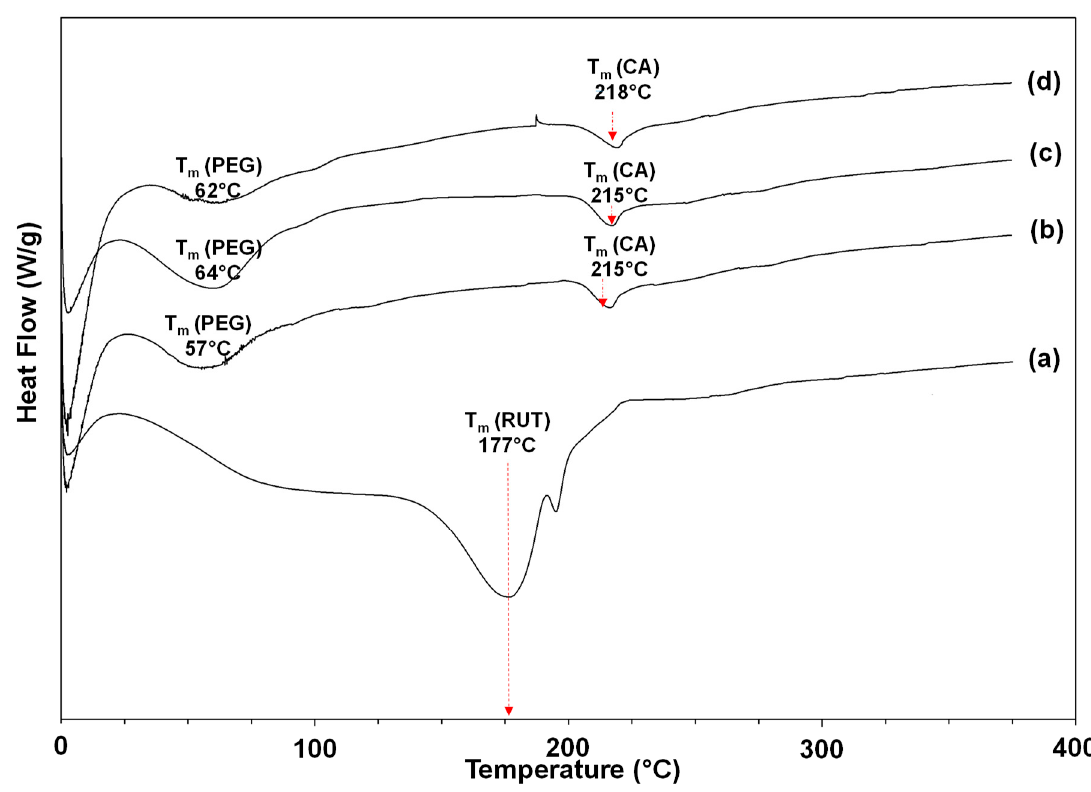
Figure 5. DSC thermograms of: ( a ) rutin (powder), ( b ) CA/PEG/RUT mat, ( c ) CA/PEG/QUE/RUT mat, and ( d ) CA/PEG/QUE+CA/PEG/RUT mat.